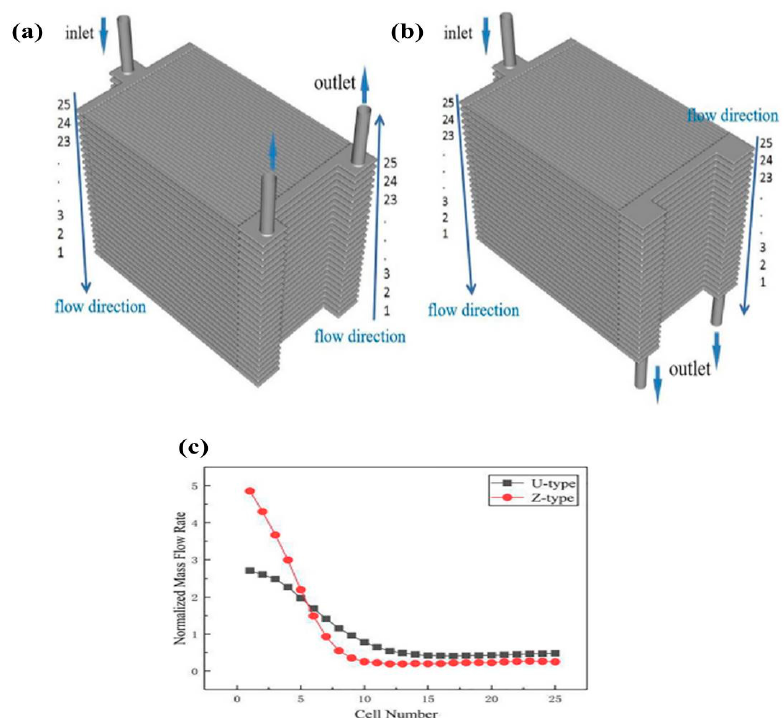
Figure 6. 3D model of ( a ) U-type, ( b ) Z-type air-flow channels used in 25-cell PCFC stacks, and ( c ) analysis of normalized air flow rate through these channels. Reproduced with permission from reference [39], copyright 2022, Springer.